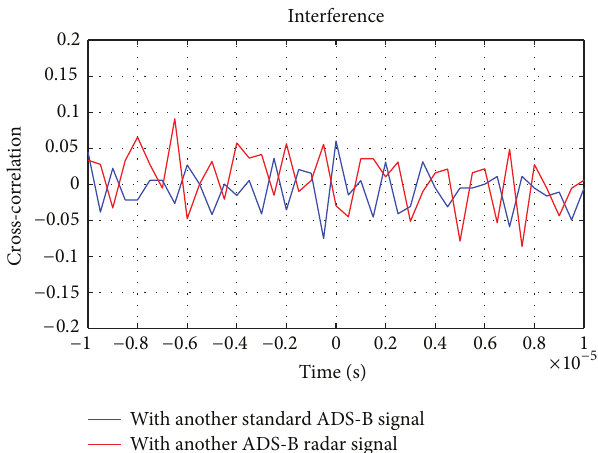
Figure 5: Cross-correlation of a standard phase-modulated ADS- B signal with another standard ADS-B signal and another phase- modulated ADS-B radar